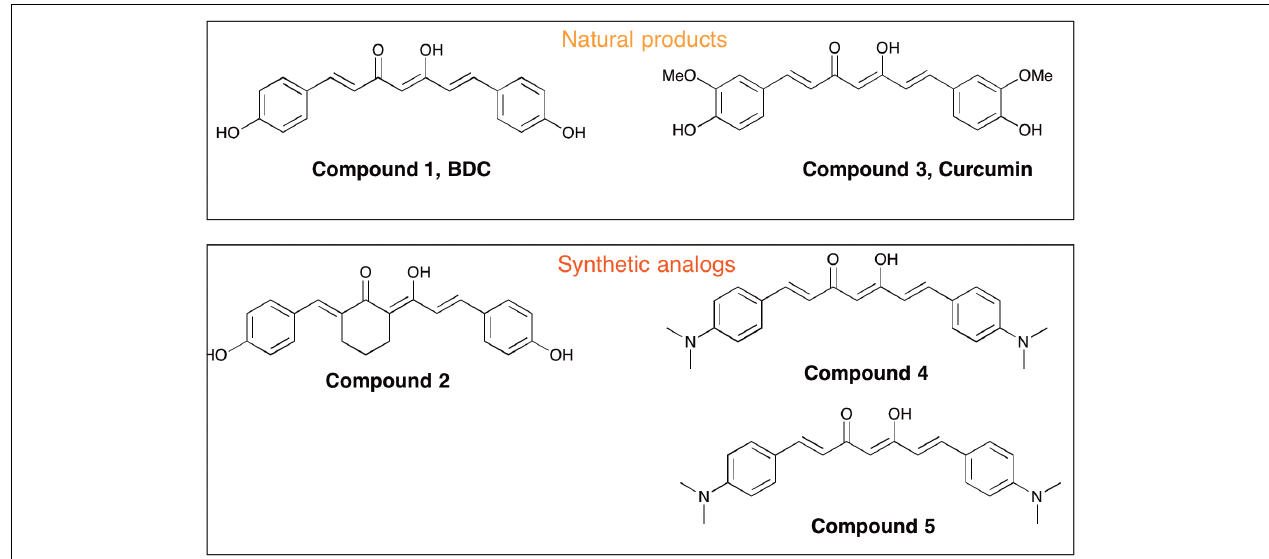
FIGURE 1 | Chemical structures of curcuminoids used for cell